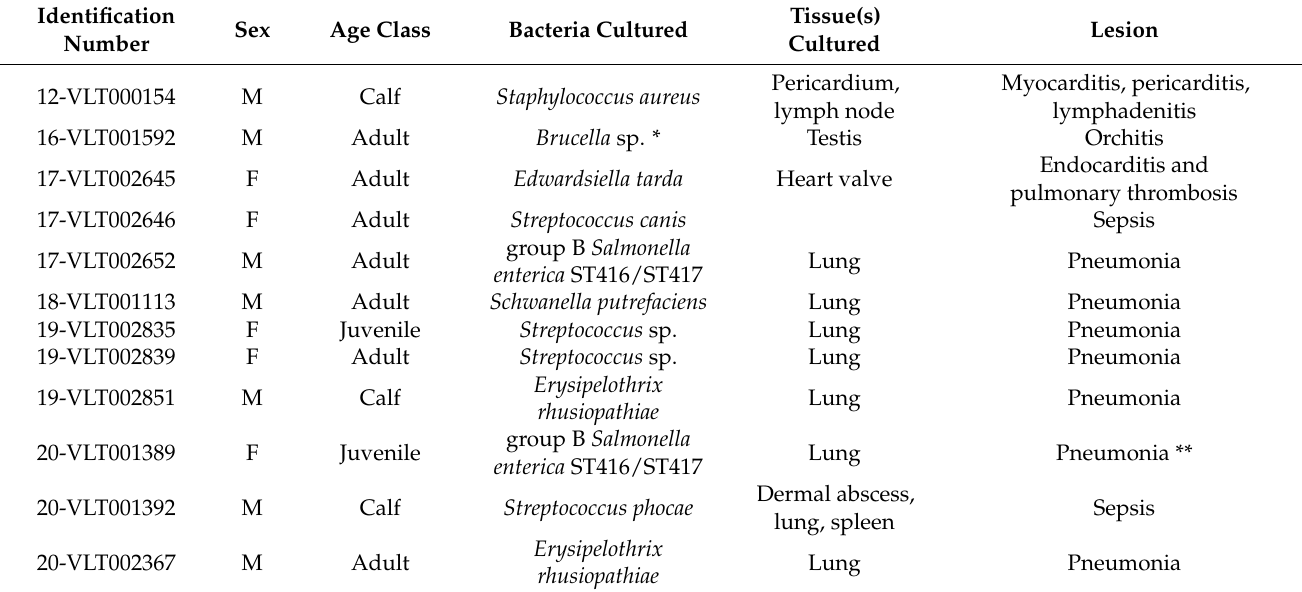
Table 1. Bacterial infections of stranded harbour porpoises ( Phocoena phocoena ) examined form Swedish waters from 2006 to 2020.